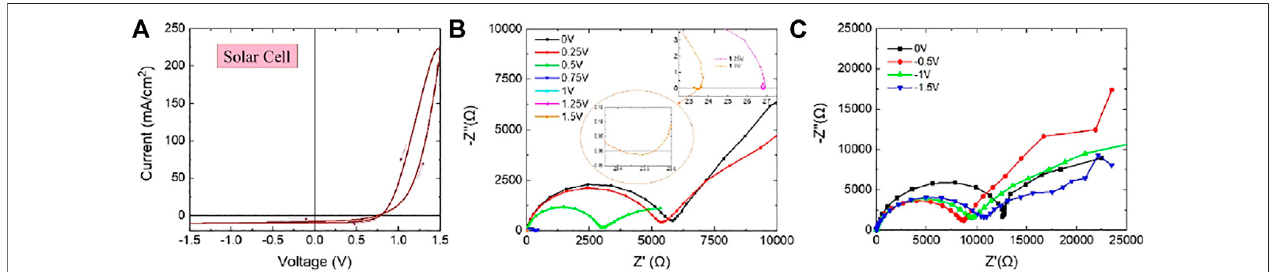
2 /m-TiO 2 /MAPI/spiro-OMeTAD/Au solar